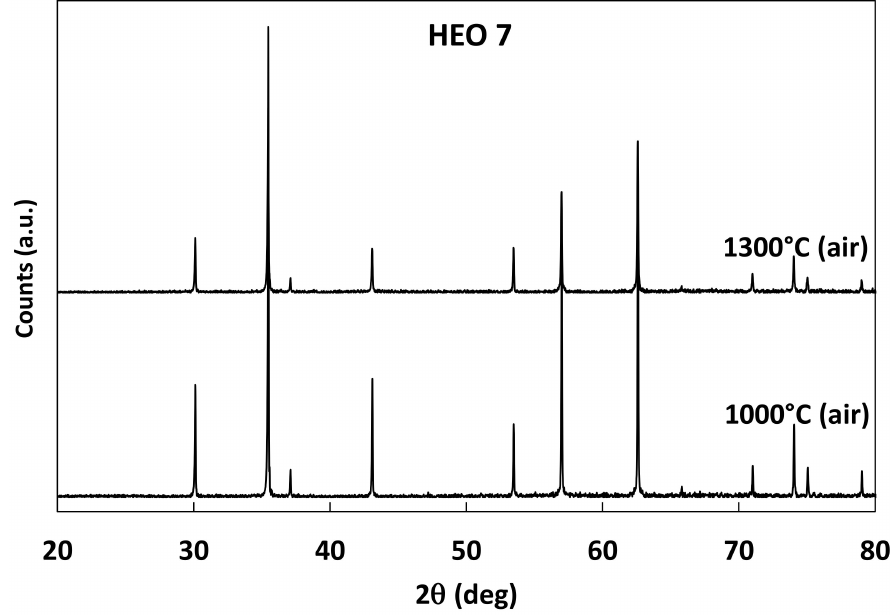
Figure 12. XRD analysis of HEO 7 after annealing at 1000 ◦ C and 1300 ◦ C in air for 1